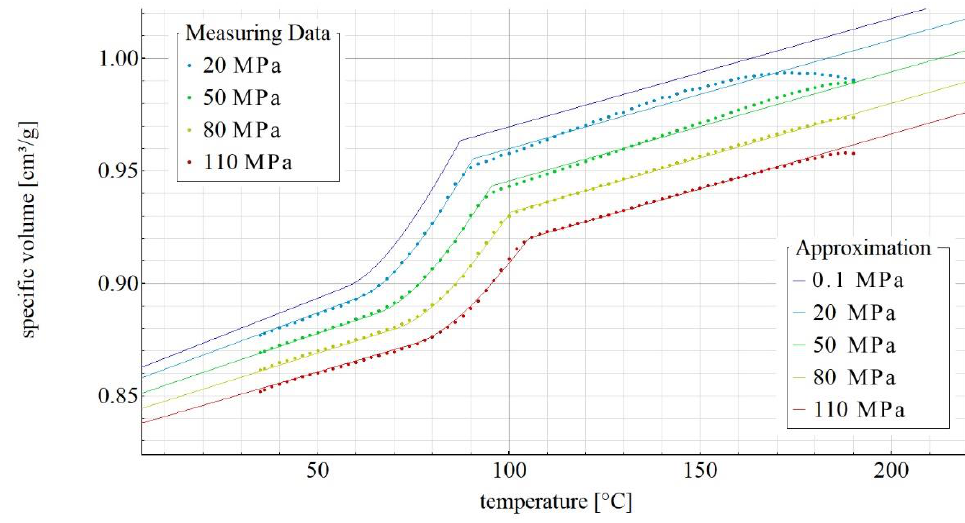
Figure 2. p-v-T diagram for pure poly(butylene succinate).